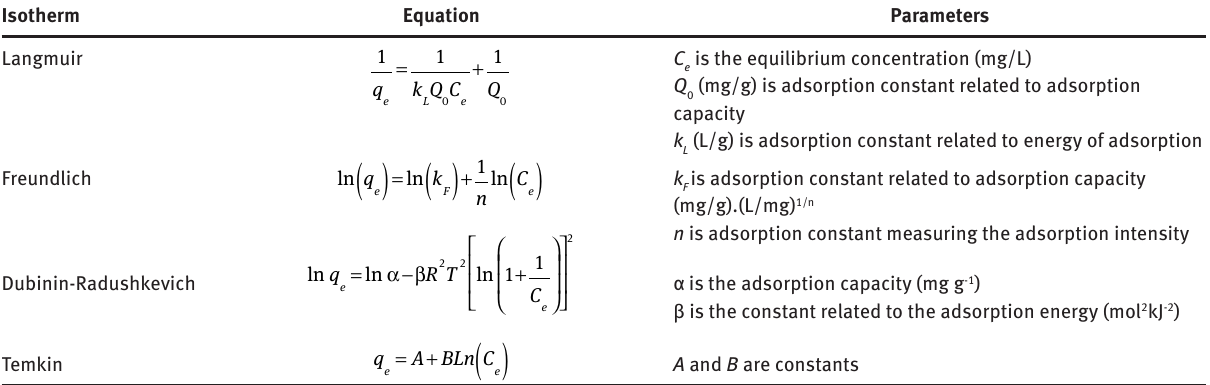
Table 2: Adsorption isotherm models adopted in this work and their parameters. Isotherm